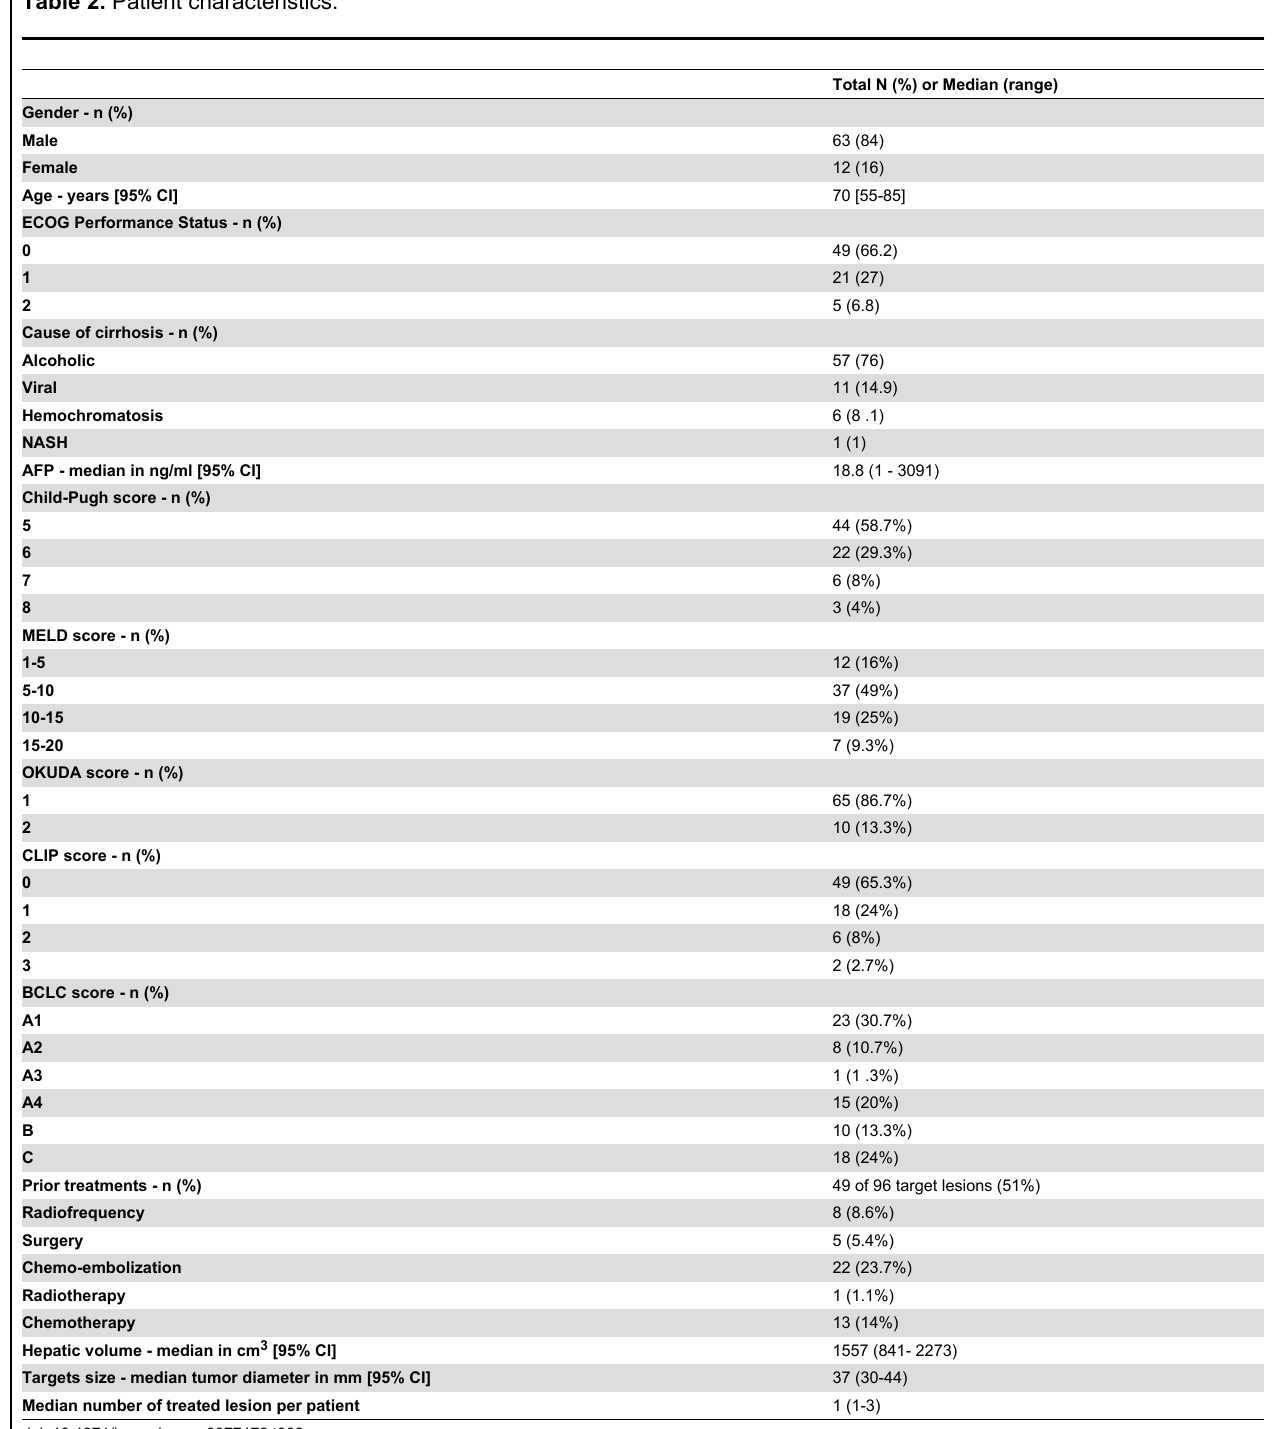
Table 2. Patient